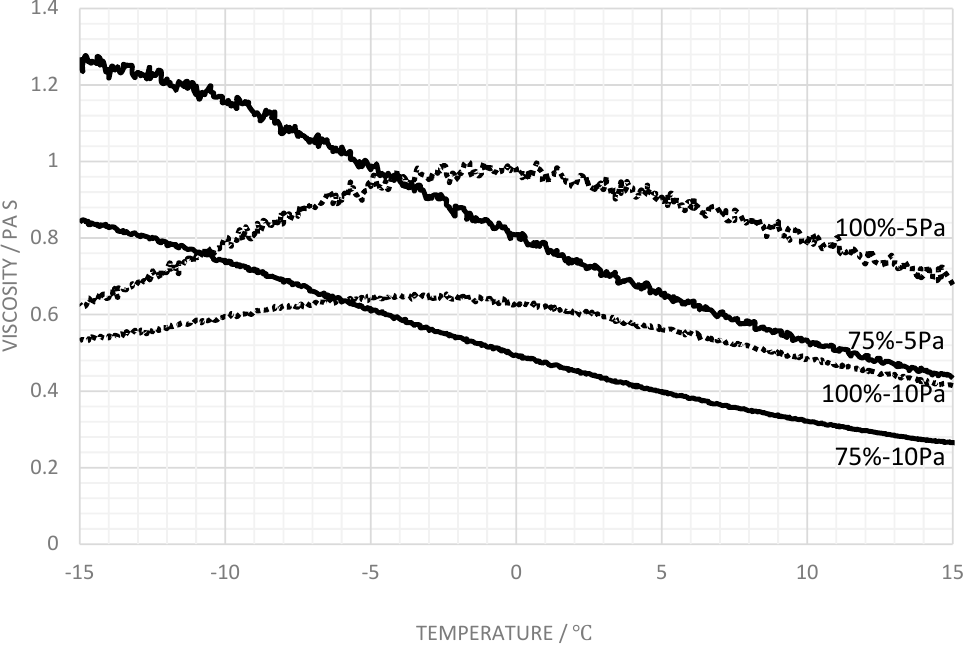
Figure 3. Viscosity variation for the base fluid and a 75 wt% dilution at shear stresses of 5 and 10 Pa.